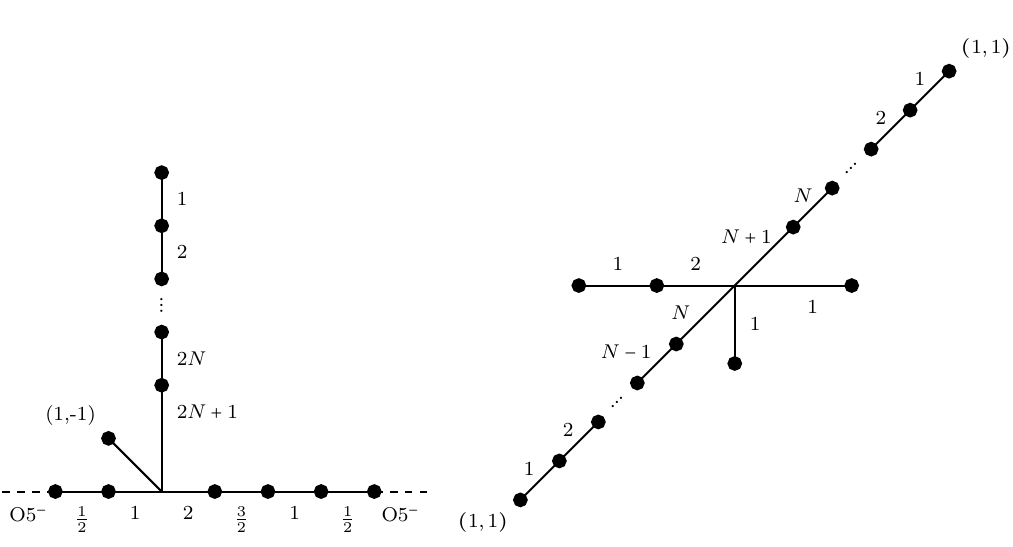
Figure 7. Brane webs for EQ 4 , 4 (left) and EQ 4